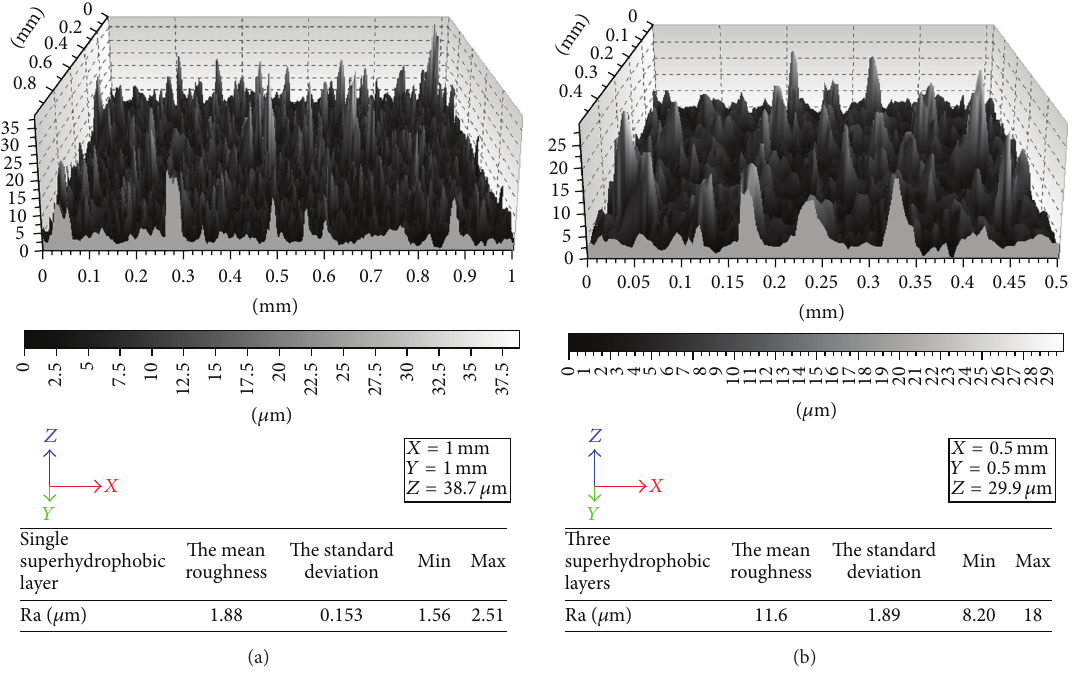
Figure1:Imagesofthe3Dtopographicsurfaceobtainedbyprofilometryfor(a)asinglesuperhydrophobiclayerand(b)threesuperhydropho- bic